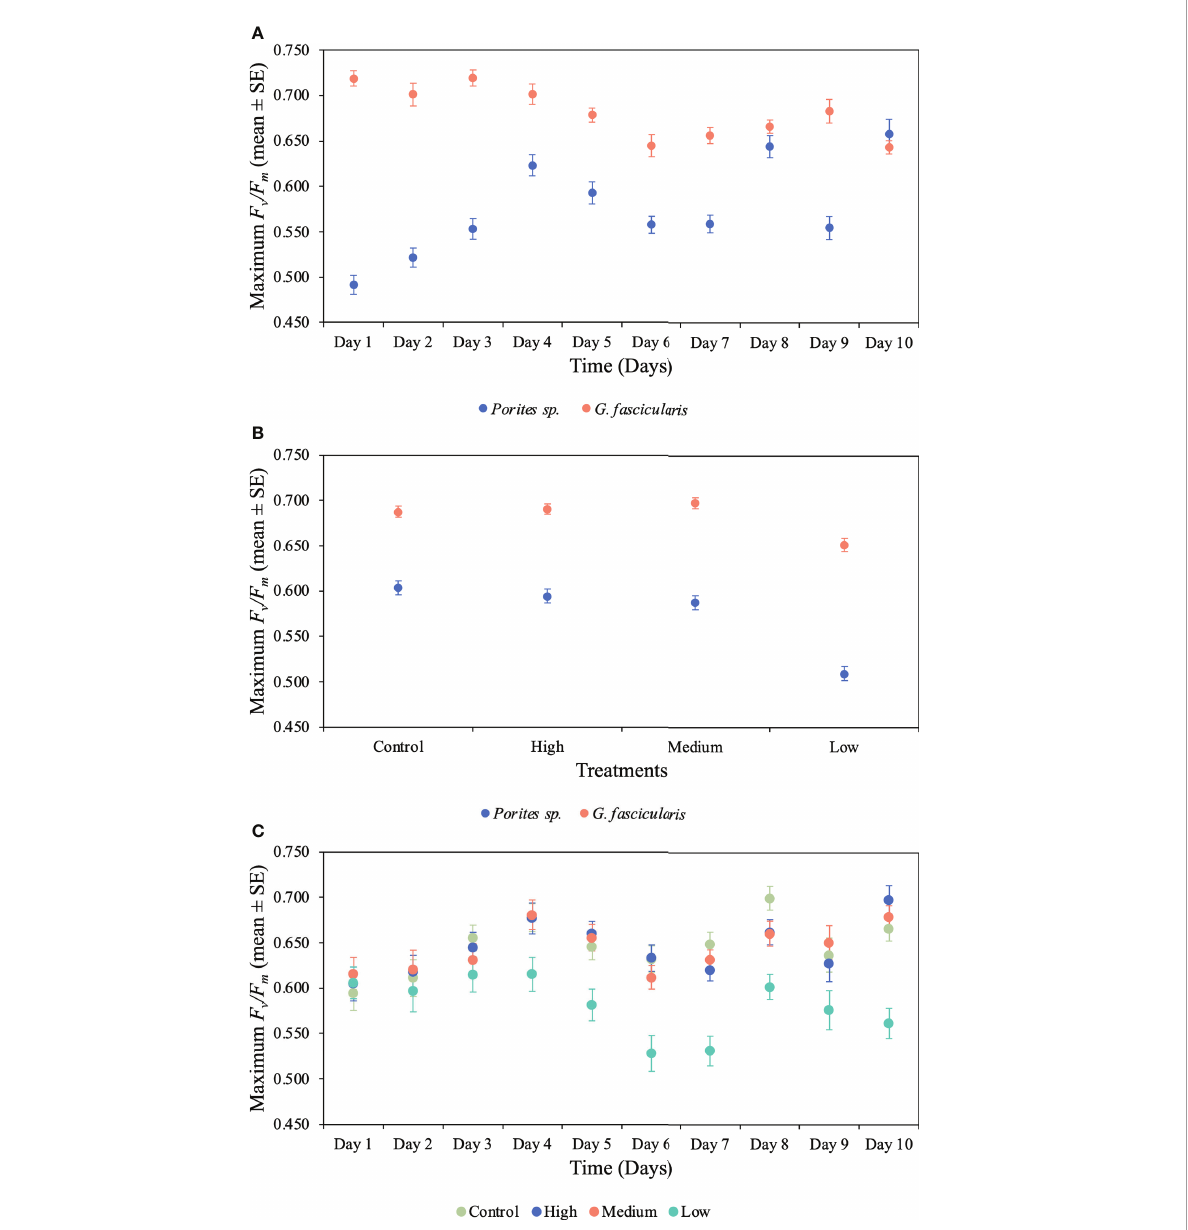
Porites sp. and G. fascicularis under all four 2 treatment for